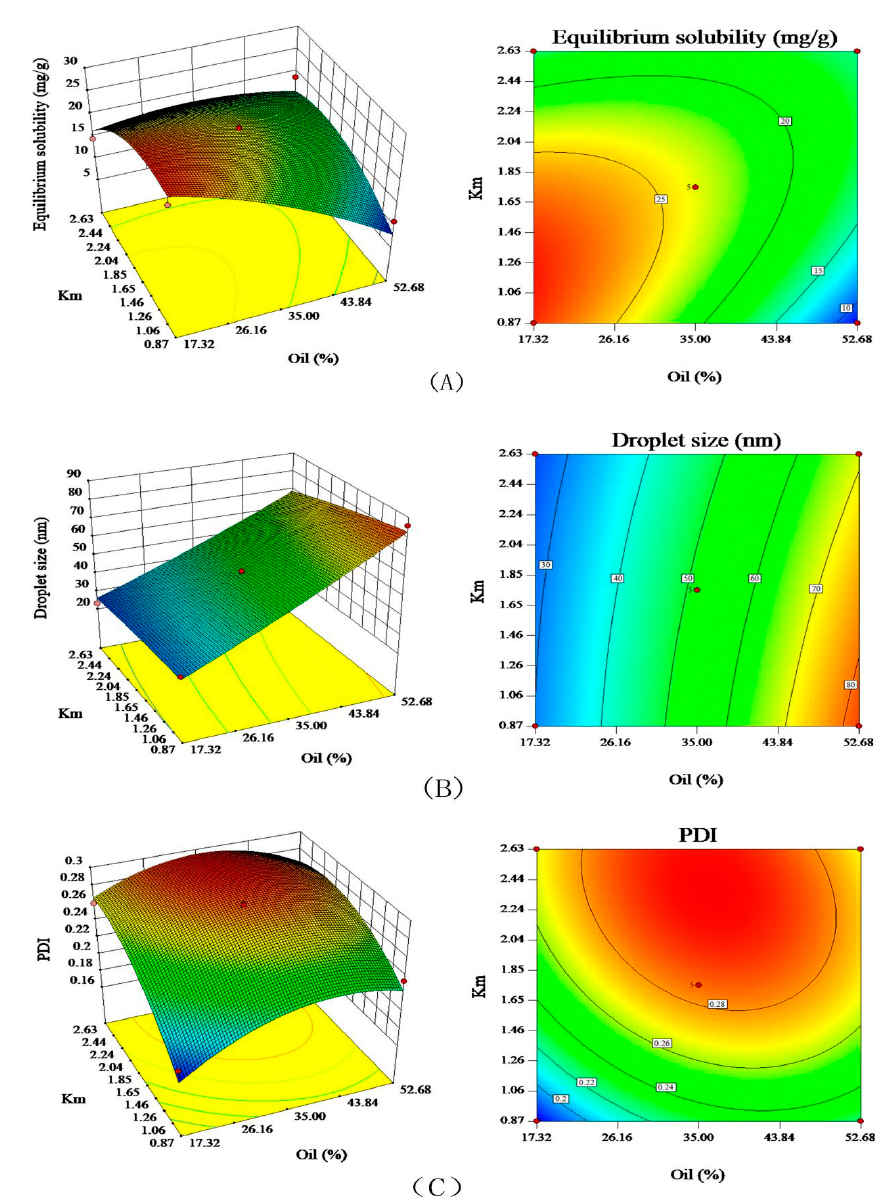
Figure 4. Response surfaces and contour plots of equilibrium solubility, droplet size and PDI. ( A ) equilibrium solubility, ( B ) droplet size, and ( C ) PDI.